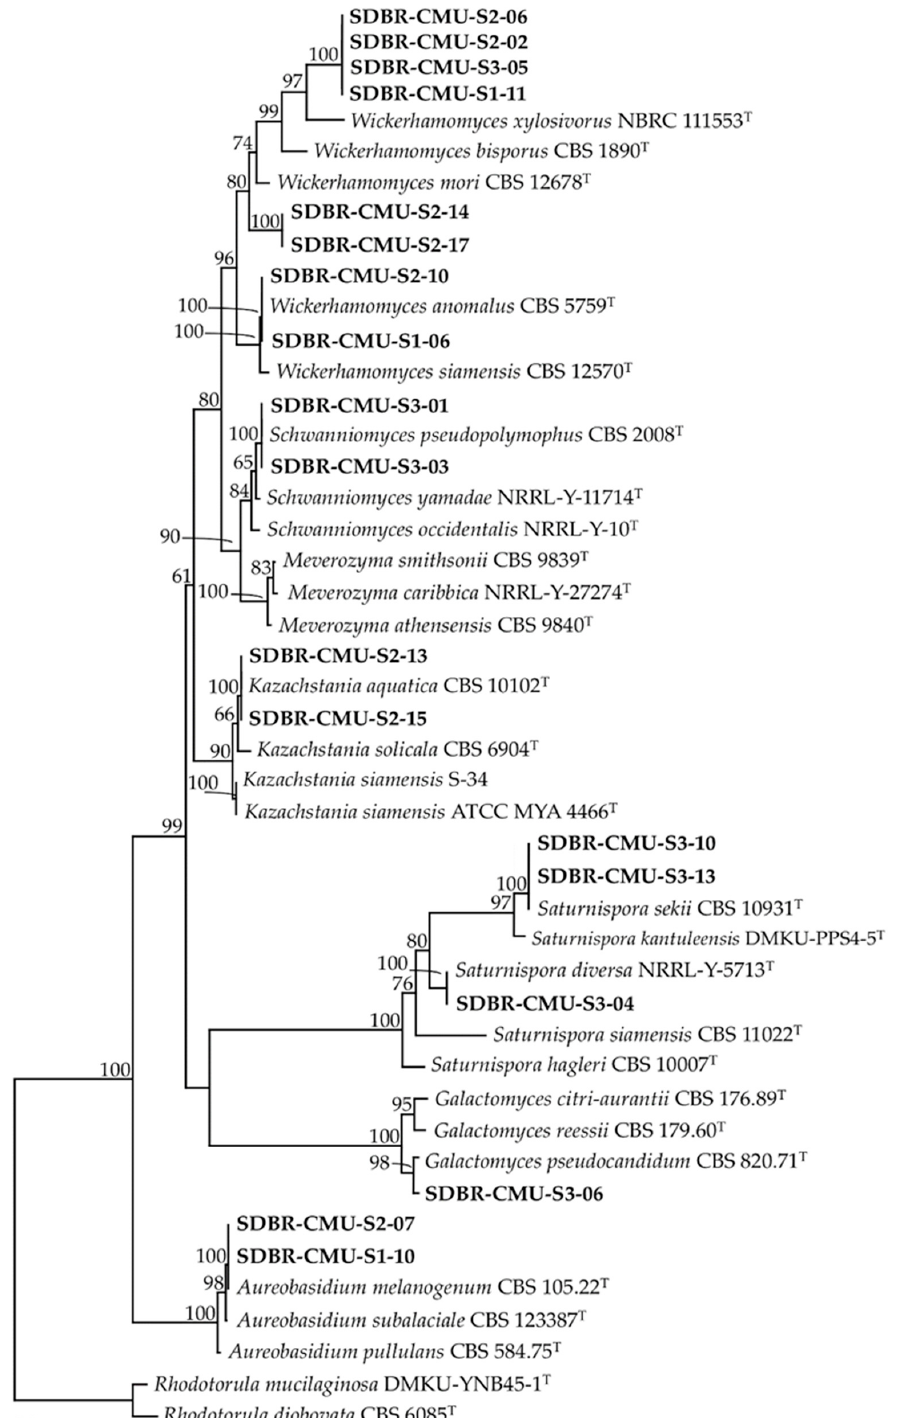
Figure 3. Phylogenetic tree of ascomycetous yeast derived from maximum likelihood analysis of the D1/D2 region of the LSU rRNA gene. Moesziomyces antarctica and M. aphidis were used as outgroup. Numbers above branches are the bootstrap statistics percentages. Branches with bootstrap values ≥ 50% are shown at each branch and the bar represent 0.1 substitutions per nucleotide position. The yeast strains obtained in this study are in bold. Superscription “T” means the type species.